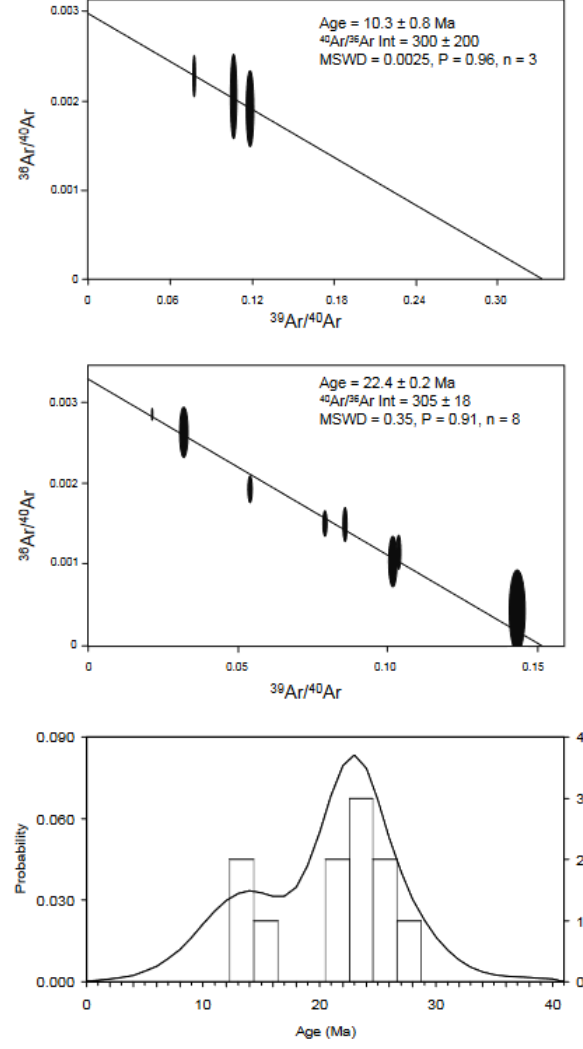
Figure 12. Isochron diagrams and probability distribution ages of kaersutitic amphibole in the sample from 37.64 m at Site 346 (Middle Miocene, Unit 2a).